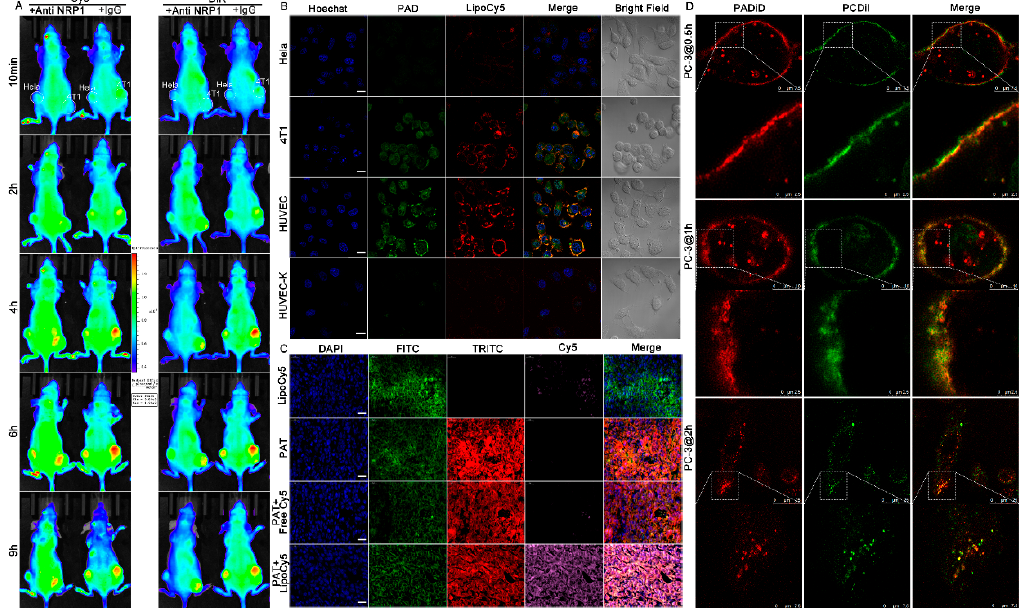
Figure 3. NRP1-mediated CoE process for enhanced tumor enrichment of nanoparticles coadministered Figure 3. NRP1 ‐ mediated CoE process for enhanced tumor enrichment of nanoparticles with APPA self-assembled peptosomes. ( A ) In vivo colocalization analysis of coadministered PADiR coadministered with APPA self ‐ assembled peptosomes. ( A ) In vivo colocalization analysis of and LipoCy5 nanoparticles. HeLa xenograft tumors are on the left flank of the mice and 4T1 xenograft tumors are on the right. The fluorescence images of Cy5 (left) and DiR (right) probes were taken for each mouse treated with either anti-NRP1 antibody or IgG; ( B ) confocal fluorescence images of HeLa, 4T1, HUVEC, and HUVEC-K (siRNA-mediated NRP1 knockdown of HUVEC) cells incubated with PAD and LipoCy5 nanoparticles (Hoechst: blue, PAD: green, LipoCy5: red, scale bars: 25 µ m); ( C ) colocalization analysis of PAT and LipoCy5 in tumor tissues using immunofluorescence staining (DAPI: blue, FITC-anti-Na + / K + ATPase antibodies: green, TRITC: red, Cy5: pink, and scale bars: 20 µ m); ( D ) stimulated emission depletion (STED) fluorescence images showing the details of the CoE process in super resolution (PADiD: red and PCDiI: